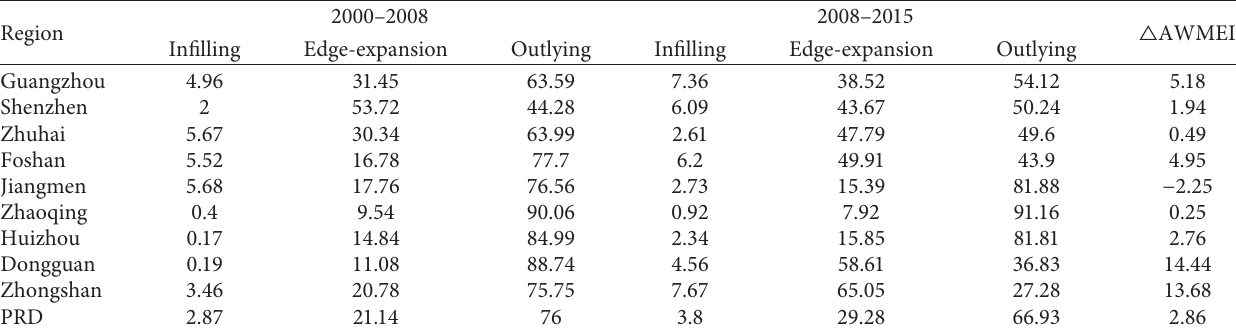
Table 3: Changes of the urban landscape expansion index of the Pearl River Delta urban agglomeration during 2000–2008 and 2008–2015(%).